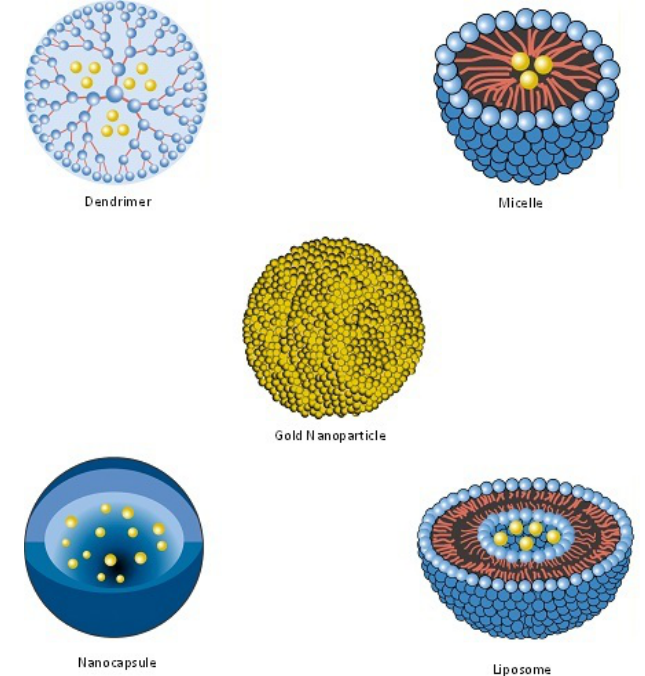
and efavirenz into macrophages [102,106,107]. Micelles : Improve the aqueous solubility, oral bioavailability and taste of efavirenz [45–49]. Nanocapsules : Increase the uptake of indinavir into the brain [95]. Liposomes : Deliver AZT and 2',3' dideoxyinosine preferentially to the RES